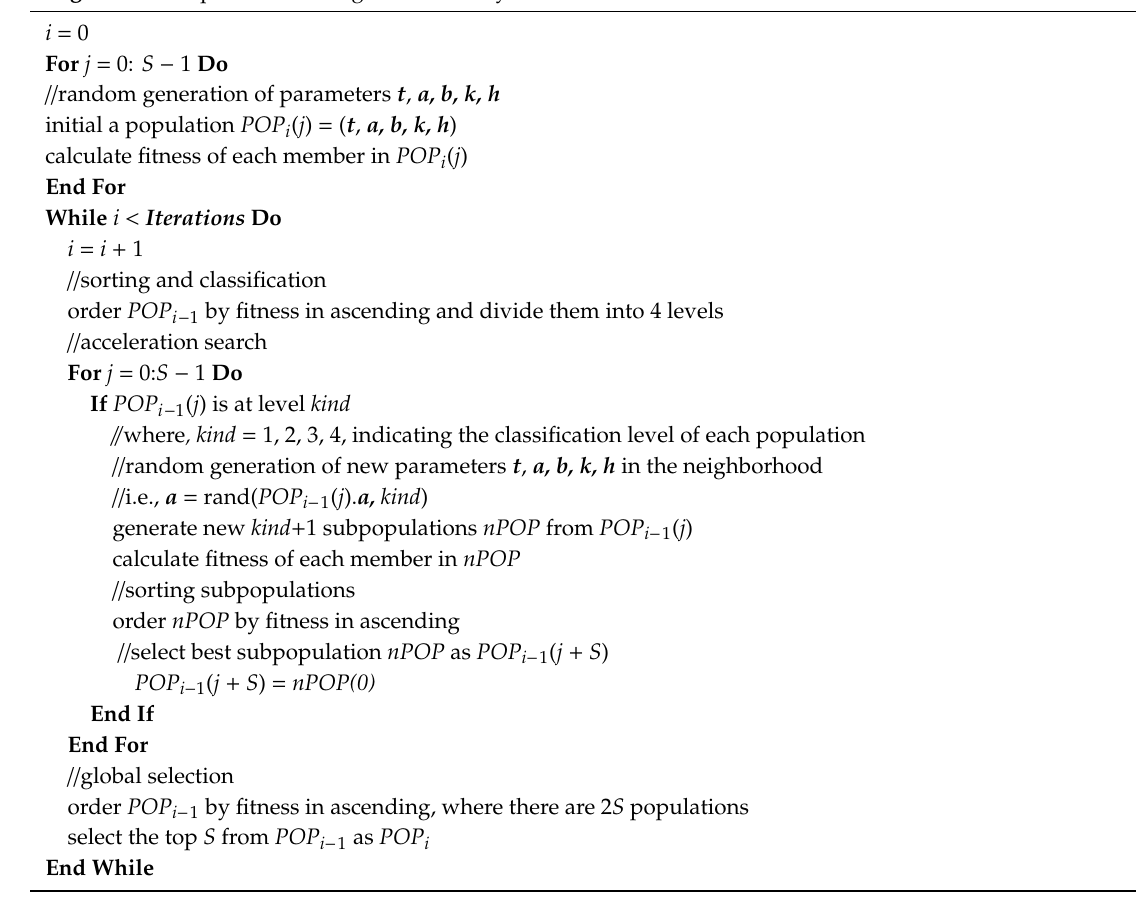
Algorithm 1. Optimal matching calculation by